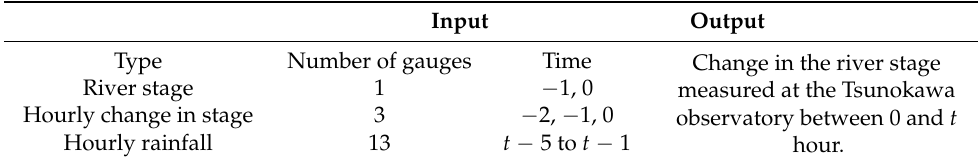
Table 4. The input and output variables for the Hitokoto’s MLP model. The time of each piece of data is shown relative to the current time, and the lead time t given in